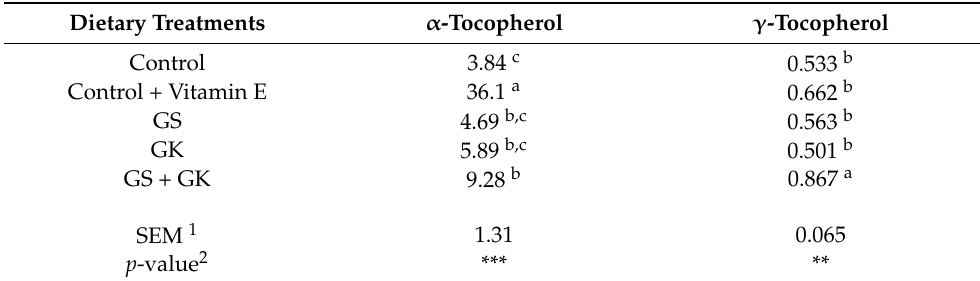
Table 6. Effect of dietary inclusion of grape seed (GS) meal, grape skin (GK) meal or vitamin E on blood α - and γ -tocopherol concentration ( µ g/mL) in 21-day old broiler chickens. Dietary Treatments α -Tocopherol γ -Tocopherol Control 3.84 c 0.533 b Control + Vitamin E 36.1 a 0.662 b GS 4.69 b,c 0.563 b GK 5.89 b,c 0.501 b GS + GK 9.28 b 0.867 a SEM 1 1.31 0.065 p -value